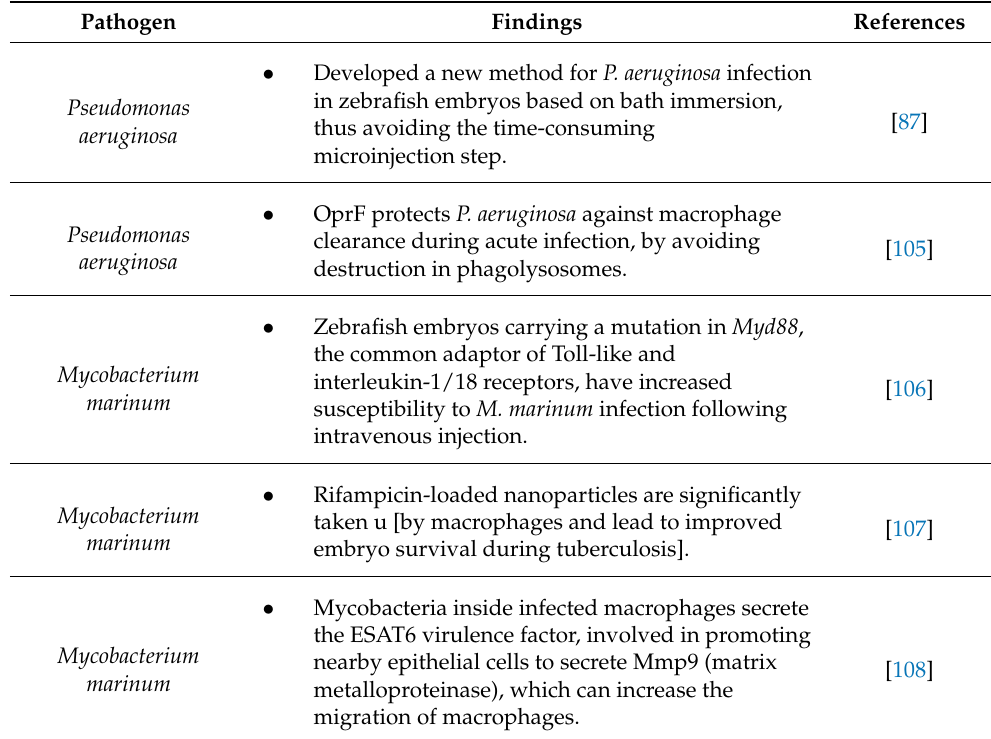
Table 2. Examples of pathogen infections tested in zebrafish